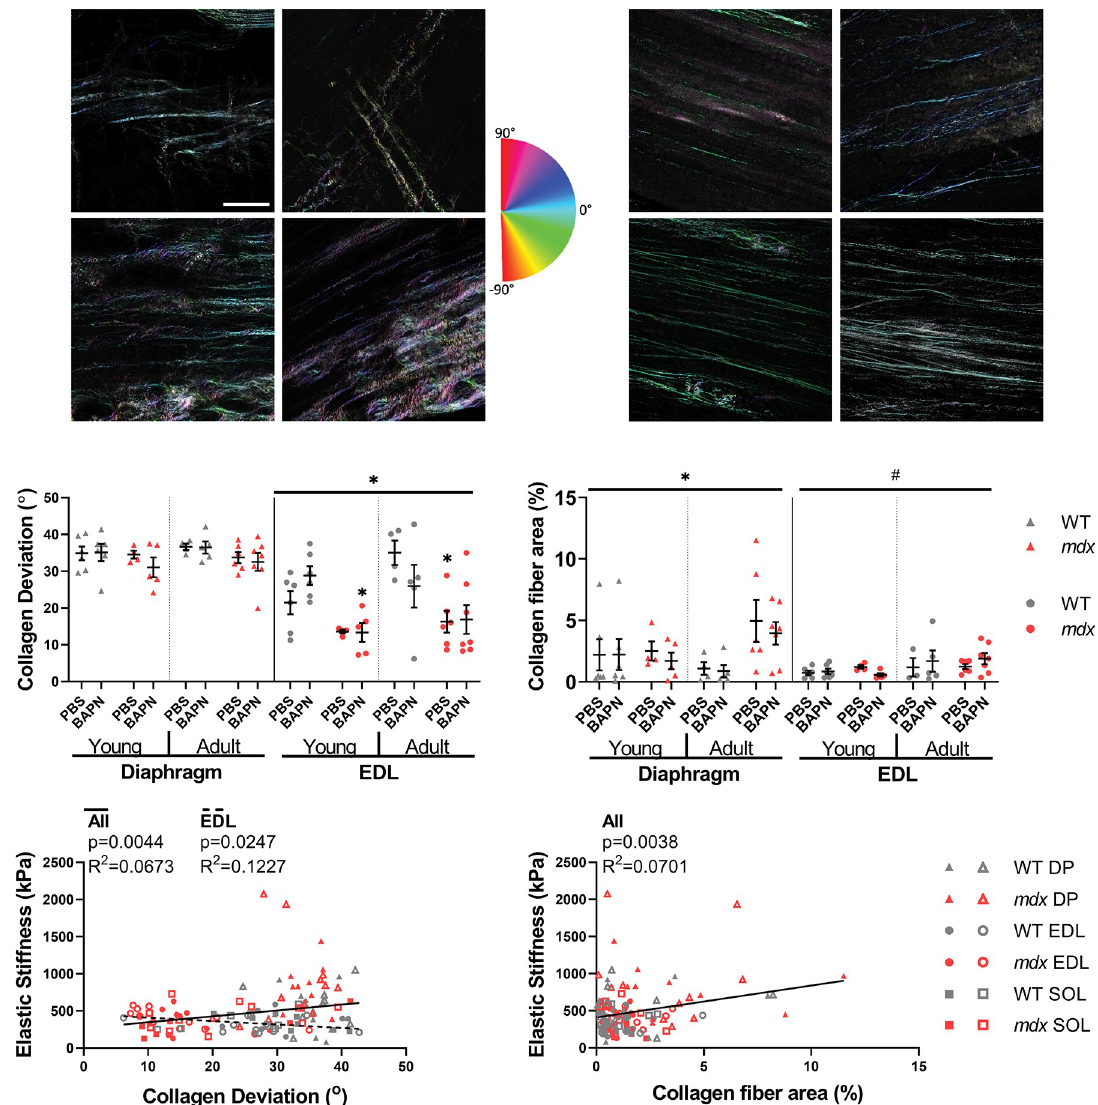
Fig 4. Second harmonic generation collagen architecture. Collagen architecture is altered in dystrophic muscle and relates to passive mechanics. (A) Second Harmonic Generation (SHG) representative images of diaphragm and EDL muscle sections from young, adult, wildtype, and mdx mice. Colormap represents angles of each pixel window in the images as analyzed by OrientationJ. Scale bar is 100 μ m. (B) The mdx EDL had significantly lower collagen deviation (higher alignment) compared to the wildtype. (C) Collagen fiber area was increased in mdx diaphragms compared to wildtype. Adult EDL muscles had higher collagen fiber area than young EDL muscles. (D) All groups combined had a significant positive correlation of collagen deviation and elastic stiffness. The EDL had an independent significant negative correlation. (E) Collagen fiber area correlated positively with elastic stiffness across all muscles. Significance by genotype: � p < 0.05and age: #p < 0.05.